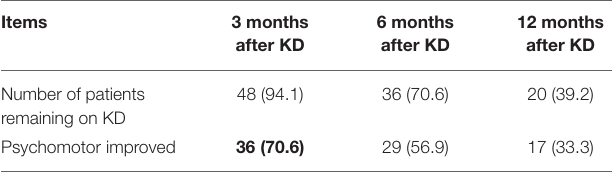
TABLE 3 | Psychomotor improvement at 3, 6, and 12 months after KD ( n , %).